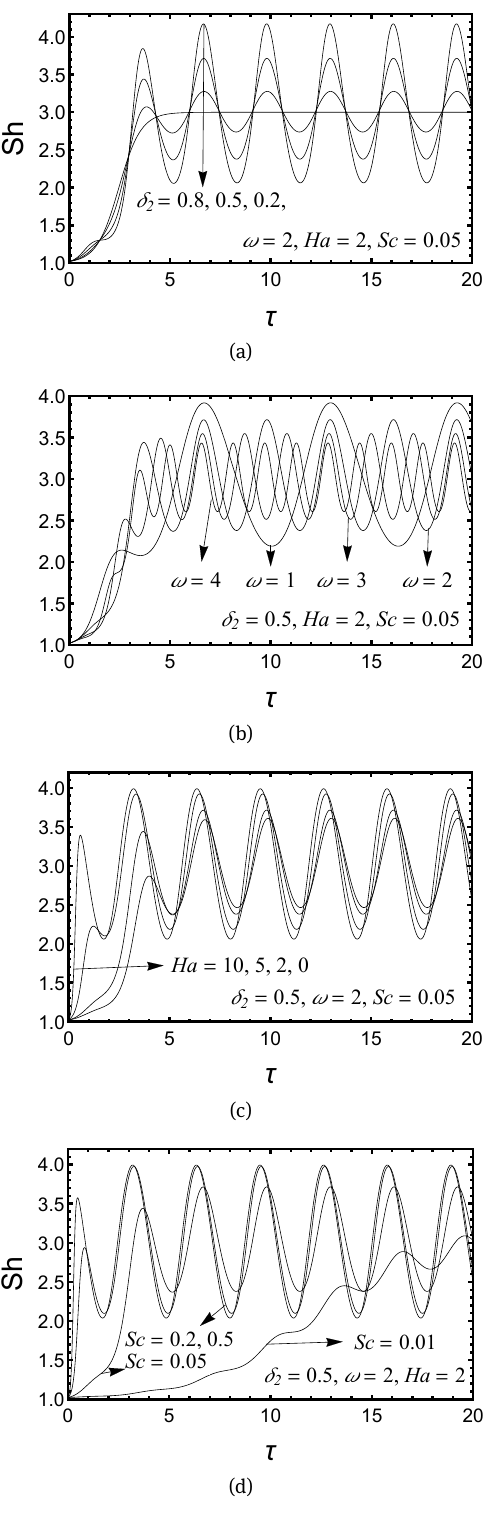
Fig. 4: Variation of Sherwood number Sh with time τ for gravity modulation for different value of (a) δ 2 , (b) ω , (c) Ha , (d) Sc